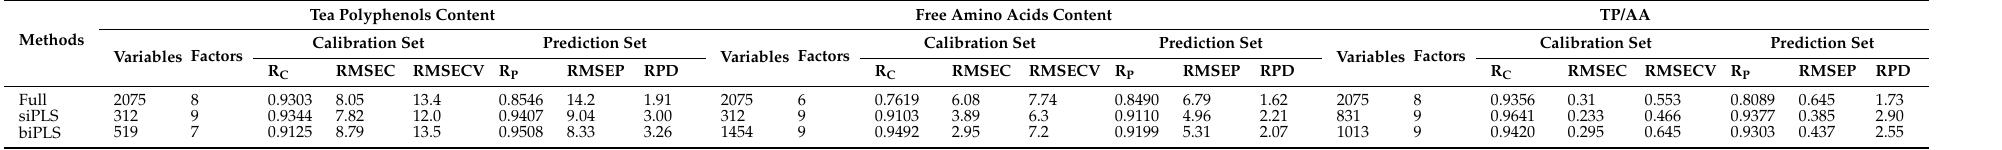
Table 3. The performance of PLS models, with different characteristic wavenumber selection procedures for the prediction of polyphenols, free amino acids content, and the polyphenols-to-amino acids